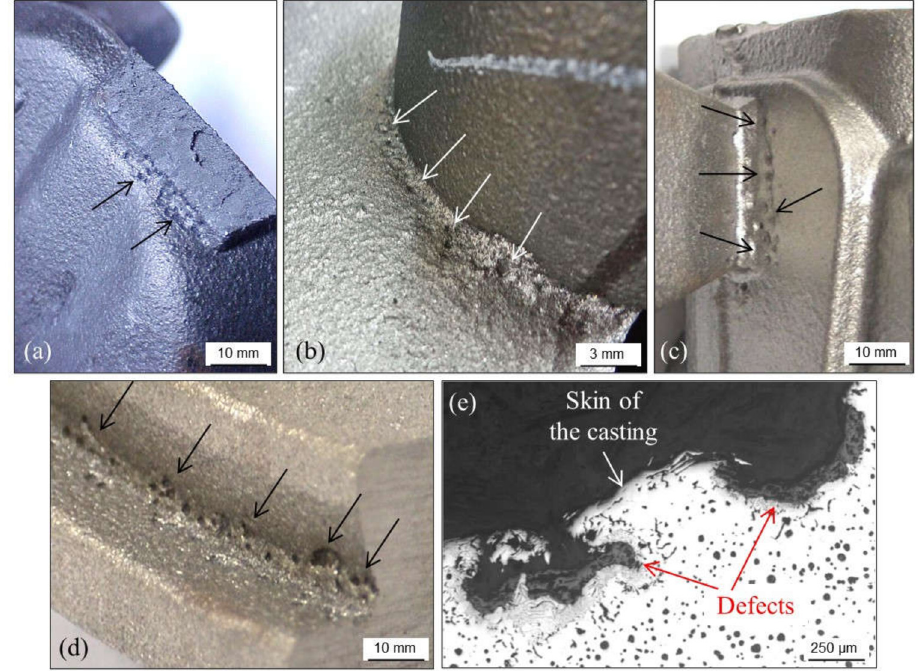
Figure 55. Hot spot defects in different ductile iron castings ( a – d ); metallographic cross section of two hot spot holes ( e